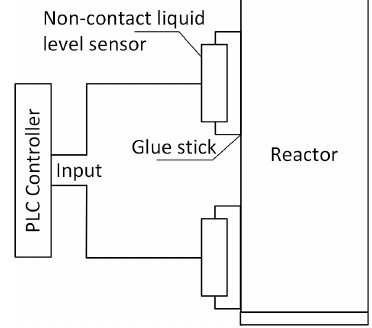
Figure 3. Placement of liquid level sensors.